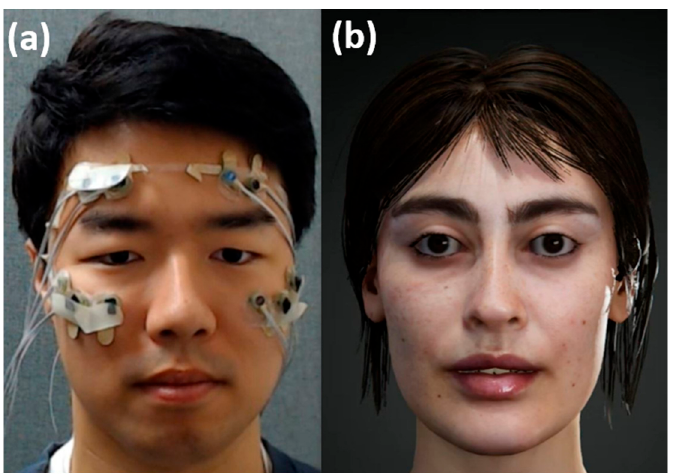
Figure 1. ( a ) A participant (third author of the paper) wearing an electrode-embedded plastic frame; ( b ) a 3D avatar used in the study.